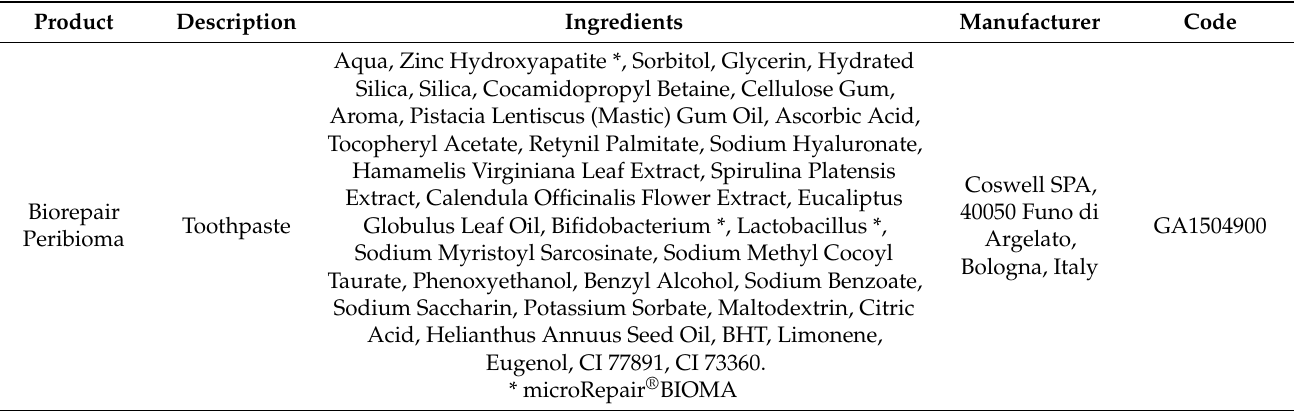
Table 1. List of the products used in the